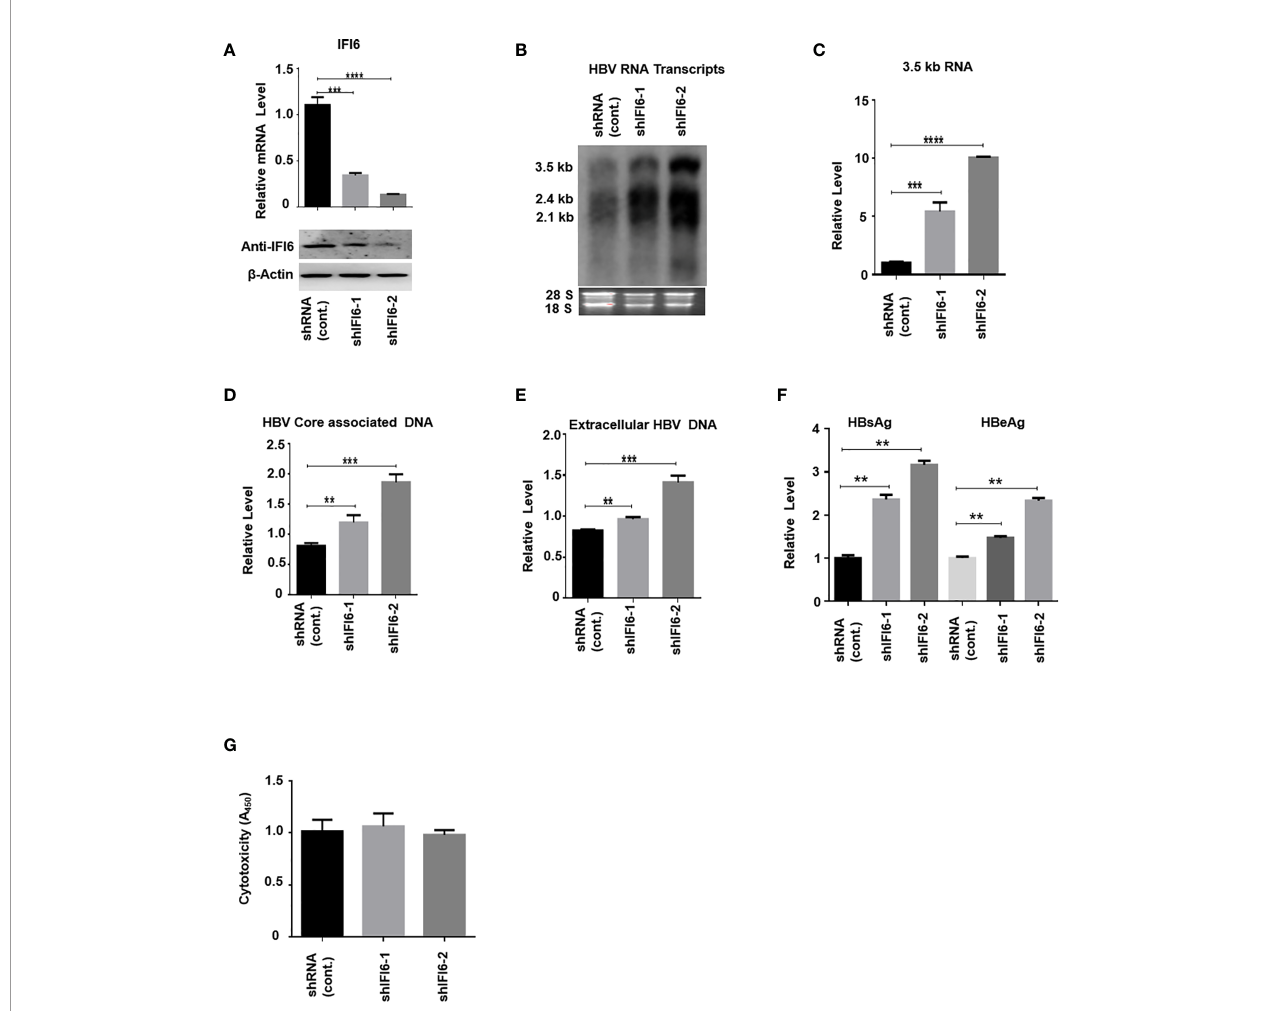
FIGURE 3 | Knockdown of IFI6 enhances HBV replication and gene expression. Stable HepG2 cell lines expressing shRNA (control), shIFI6-1, and shIFI6-2 were seeded in 12 well cell culture plate and transfected after 24 hours with pHBV1.3 (800 ng) and b -Gal (200 ng) and cells were harvested 48 hours posttransfection (A, B, C, F, G) or 96 hours posttransfection (D, E) . (A) The IFI6 mRNA and the protein expression level were measured by qRT-PCR and western blot, respectively. The anti-IFI6 antibody was used to determine the protein level of IF6. The b -actin was used as a loading control. (B) HBV RNA transcripts were determined with northern blot. The amount of 28S and 18S rRNAs was used as a loading control. (C) The level of HBV 3.5 kb RNA was measured with qRT-PCR. The GAPDH level was used as an internal control. (D) HBV core associated DNA and extracellular DNA (E) was determined with qPCR. (F) The level of secreted HBsAg and HBeAg from transfected cell supernatant was measured with ELISA. (G) The cytotoxicity of the stable knockdown cell line was determined with CCK8 kit after 48 hours of transfection with pHBV (800 ng) and b -Gal (200 ng). The data are averages of three independent experiments; the results were measured as a mean ± SD and were statistically measured. ** P < 0.01, *** P < 0.001, **** P <